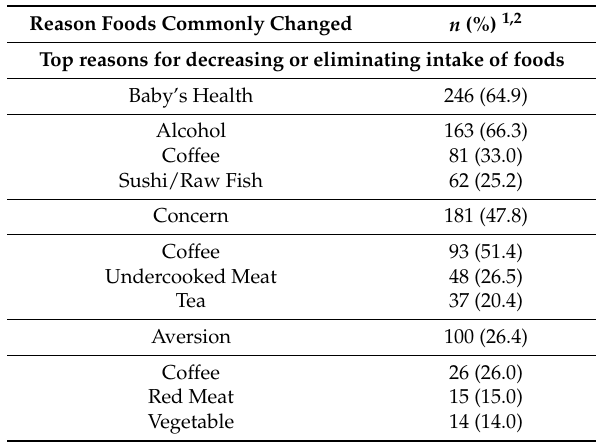
Table 4. Proportion of women who reported a specific reason for changing their dietary intake and the three most commonly cited foods associated with that